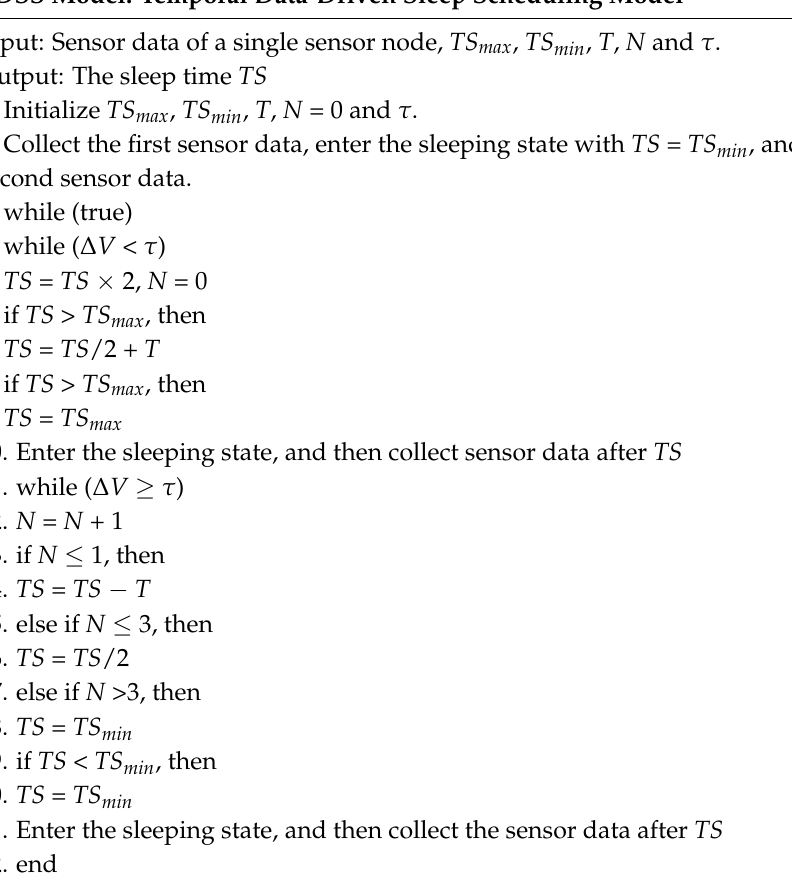
TDSS Model: Temporal Data-Driven Sleep Scheduling